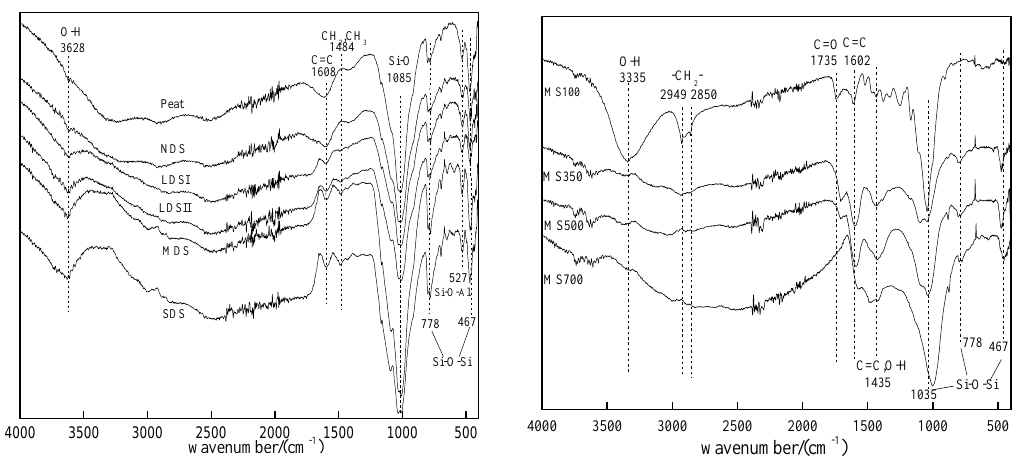
Figure 1. The FTIR spectra of the six selected soils and biochar.